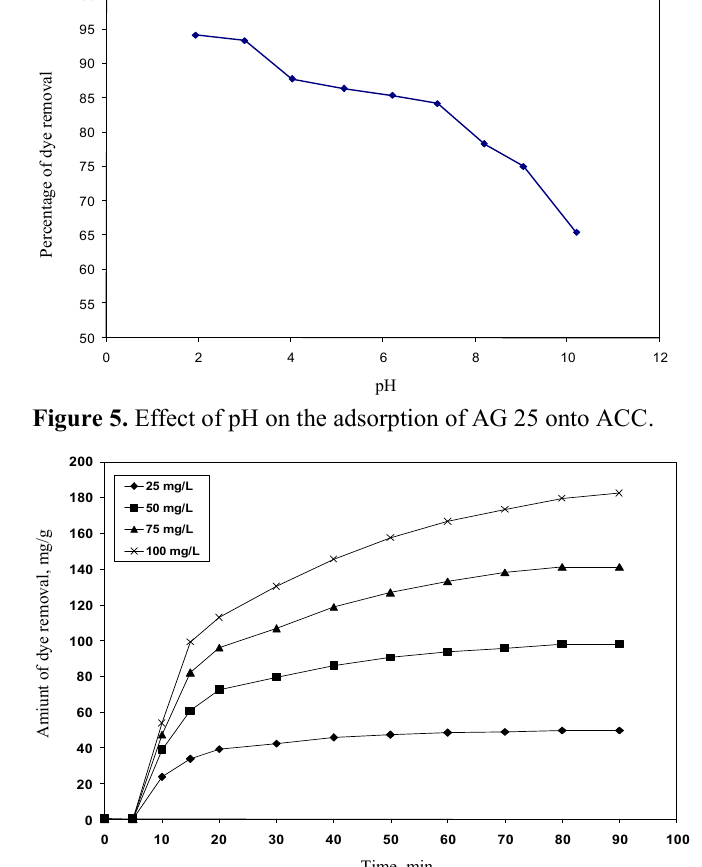
Figure 6. Effect of agitation time on the removal of AG 25 onto ACC at 303